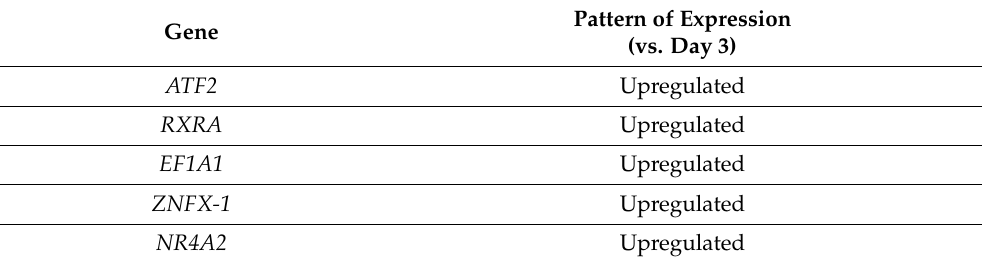
Table 4. Transcription factors with significant differential expression. Pattern of Expression Gene (vs. Day 3) ATF2 Upregulated RXRA Upregulated EF1A1 Upregulated ZNFX-1 Upregulated NR4A2